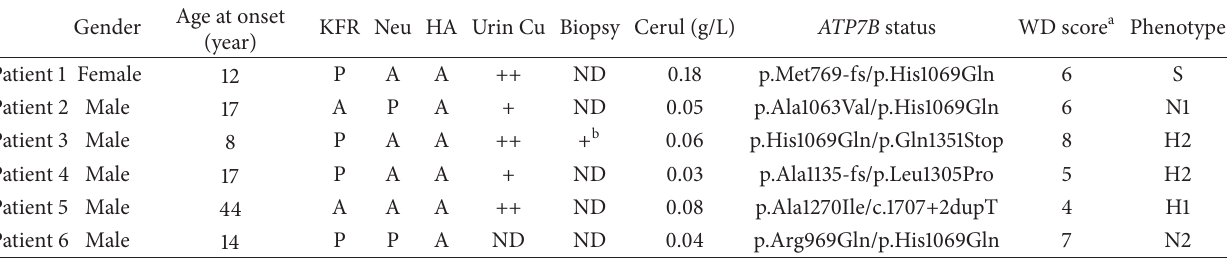
Table 1: Demographic and clinical characteristics of the patients.